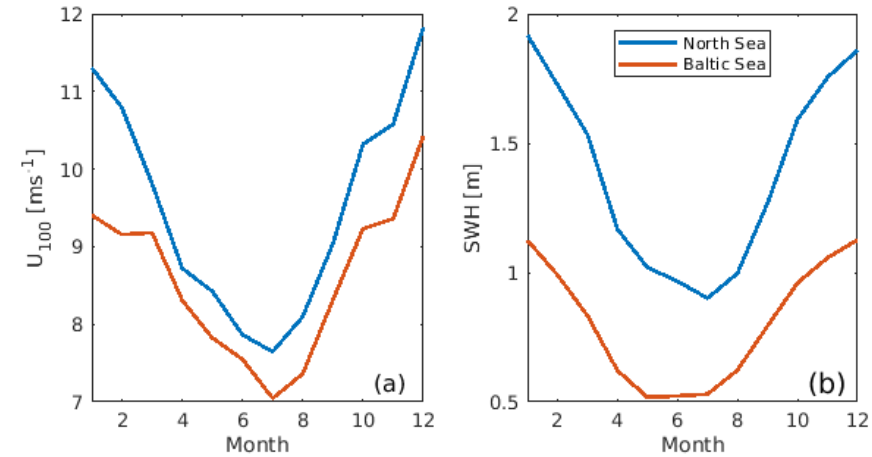
Figure 3. The average monthly wind speed at 100 m above mean sea surface ( a ) and significant wave height ( b ) during 2010–2019 over the Baltic Sea and North Sea. Only the sea points from ERA5 are used in the plot.